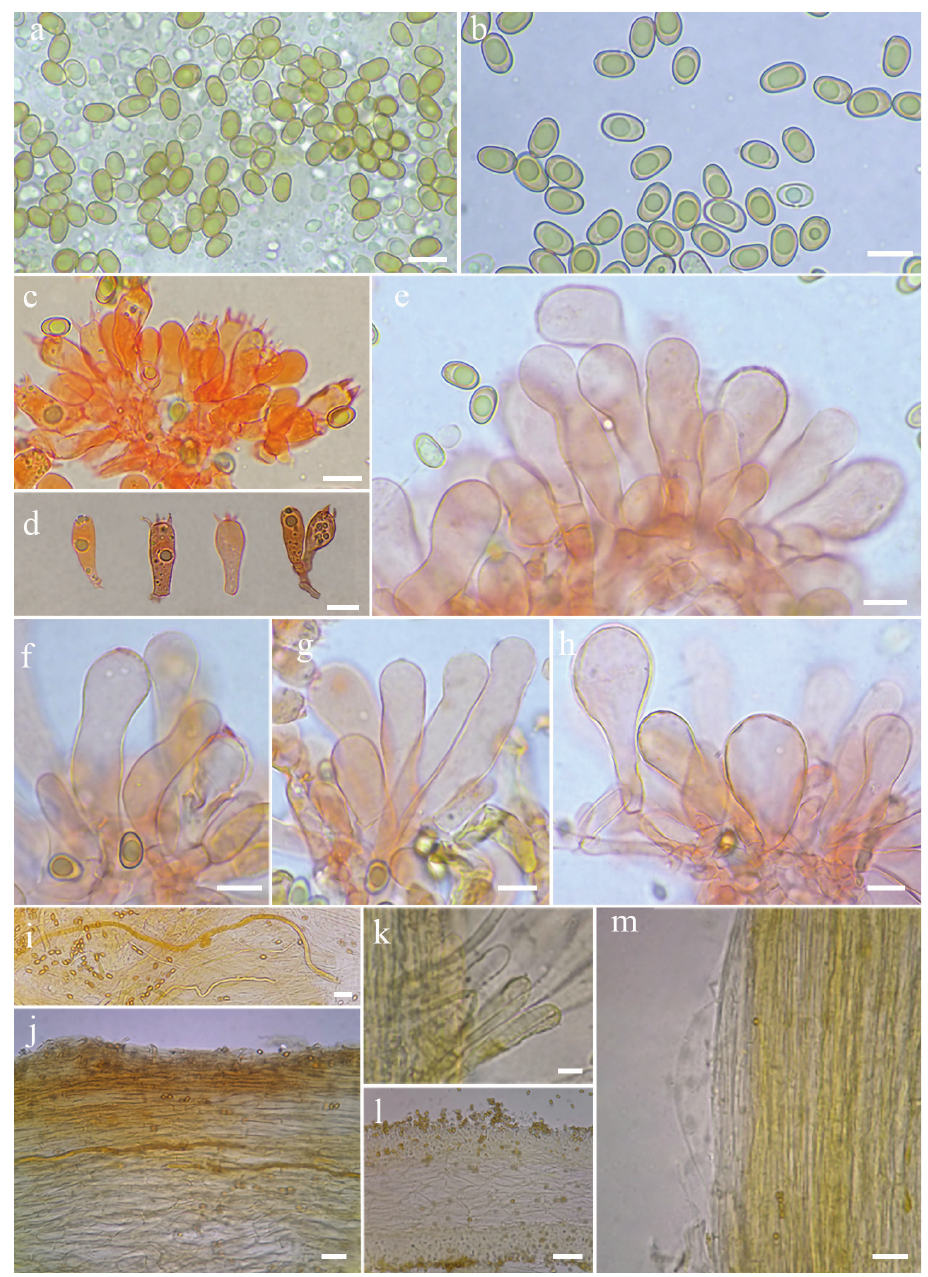
Figure 3. Microscopic features of Inosperma muscarium (FHMU3162, holotype) a–b basidiospores c–d ba- sidia e–h cheilocystidia in clusters i oleiferous hyphae j pileipellis and pileal trama k terminal hyphae at the stipe apex l hymenophoral trama m stipitipellis and stipe trama. Scale bars: 10 μm ( a–m ). Photos by L.-S.